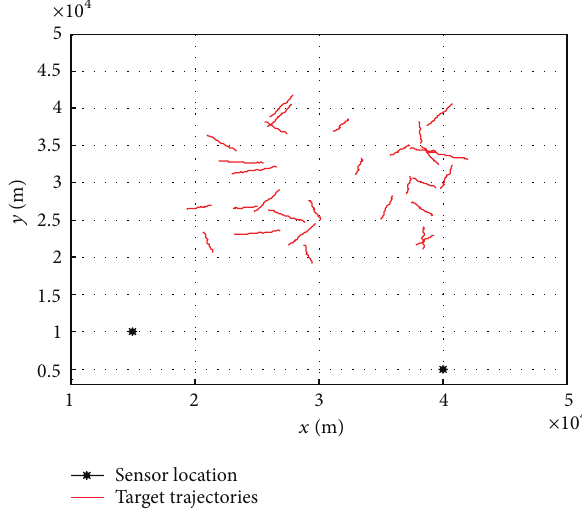
Figure 5: Sensors and target trajectories.